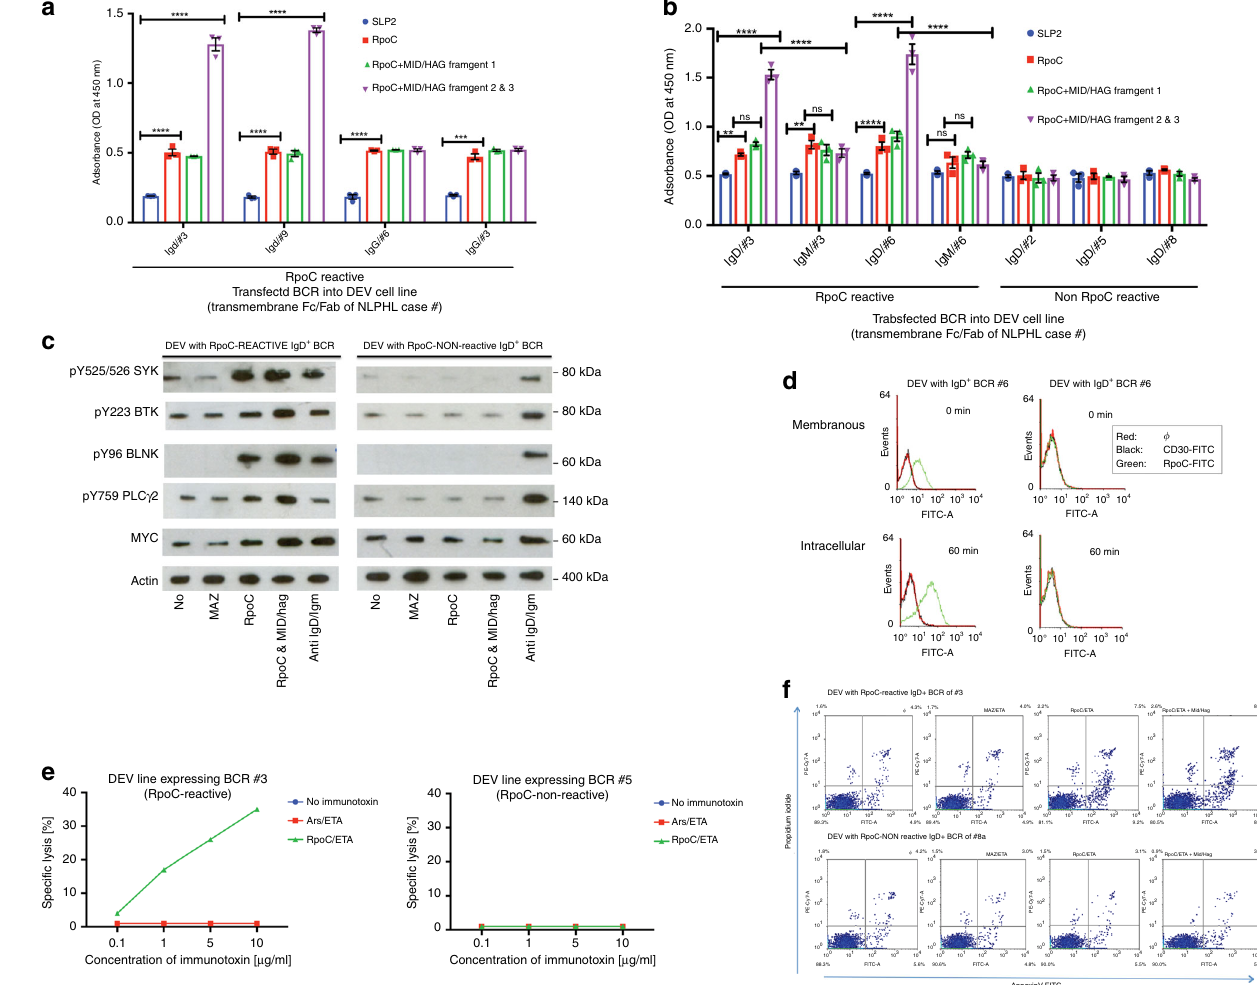
Fig. 3 Costimulation of different types of LP cells by RpoC and MID/hag. a Tetrazolium proliferation assay with the transfected DEV cells expressing recombinant BCRs with different RpoC-reactive Fab fragments and Fc fragments of either IgD or IgG class. Stimulation with RpoC resulted in signi fi cant proliferation, and costimulation with MID/hag fragments 2 and 3 resulted in strong further increase of proliferation in cell lines expressing BCR of IgD class, e.g. transfected DEV expressing IgD + BCR #3 stimulated by rec. human SLP2 vs. rec. M. catarrhalis RpoC: p < 0.00001 (DF = 32, q = 17.99); DEV expressing IgD + BCR #3 stimulated by rec. human SLP2 vs. rec. M. catarrhalis RpoC and MID/hag 2&3: p < 0.00001 (DF = 32, q = 46.22). b In a Tetrazolium assay stimulation with RpoC resulted in increase of proliferation in DEV cells expressing RpoC-reactive BCRs, but not in DEV cells expressing non-RpoC-reactive BCRs. In IgD + DEV cells with RpoC-reactive BCR incubation with MID/hag 2 and 3 resulted in a signi fi cant increase of proliferation, whereas costimulation with MID/Hag fragments 2 and 3 and the control antigen SLP2 had no additive effect. DEV expressing IgD + BCR #6 stimulated by rec. human SLP2 vs. rec. M. catarrhalis RpoC: adjusted p < 0.0001 (DF = 56, q = 7.321) and DEV expressing IgD + BCR #6 stimulated by rec. M. catarrhalis RpoC and MID/hag 2&3 vs. DEV expressing IgM + BCR #6: p < 0.00001 (DF = 56, q = 29.44). Values in a and b are mean ± SEM. Two-way ANOVA with Tukey ’ s multiple comparisons were performed, ** p ≤ 0.01, *** p ≤ 0.001, **** p ≤ 0.0001. Experiments were independently repeated three times. c Activation of the BCR-signaling pathway. Representative Western blot analysis of the BCR signaling pathway shows a strong activation by RpoC and even stronger by coincubation with RpoC and MID/hag in DEV cells transfected to express an RpoC-reactive IgD + BCR. The incubation with RpoC, RpoC&Mid/ Hag, or anti-IgM/IgD antibody results in the upregulation of the activated isoforms pTyr525/526 SYK, pTyr96 BLNK, pTyr759 PLC γ 2, and pTyr223 BTK and induced overexpression of MYC. d Binding and internalization of RpoC/FITC into LP cells. RpoC/FITC bound to DEV cells transfected to express recombinant BCR of case #6 with RpoC-reactivity, but not to DEV cells transfected to express recombinant BCR of case #5. After 60 min internalization of RpoC/FITC into DEV cells with the RpoC-speci fi c BCR #6 was observed. Control CD30/FITC neither bound to DEV cells nor was internalized. e Dose- dependant cytotoxic effects by ETA ’ toxin-conjugated RpoC dependent on expression of RpoC-reactive BCRs on LP cells. Speci fi c cytotoxicity evoked by RpoC/ETA ’ was observed in the DEV cell line expressing the RpoC-reactive BCR of patient #3 (left), but not in the one expressing the autoreactive BCR of patient #5 (right). f Apoptosis induced by ETA ’ toxin-conjugated RpoC dependent on expression of RpoC-reactive BCRs on LP cells. Characterization of DEV cells stably transfected to express IgD + recombinant BCRs with (above, from case #3) or without (below, from case #8a) reactivity to M. catarrhalis RpoC by Annexin-V/FITC and propidium iodide staining after 24 h cultivation in the presence of RpoC/ETA, MAZ/ETA, or RpoC/ETA together with MID/ hag. RpoC/ETA induced speci fi cally apoptosis in the DEV cell line with RpoC-reactive BCR. Data in a – c and f are representative of three independent experiments, data of d and e are representative of two independent